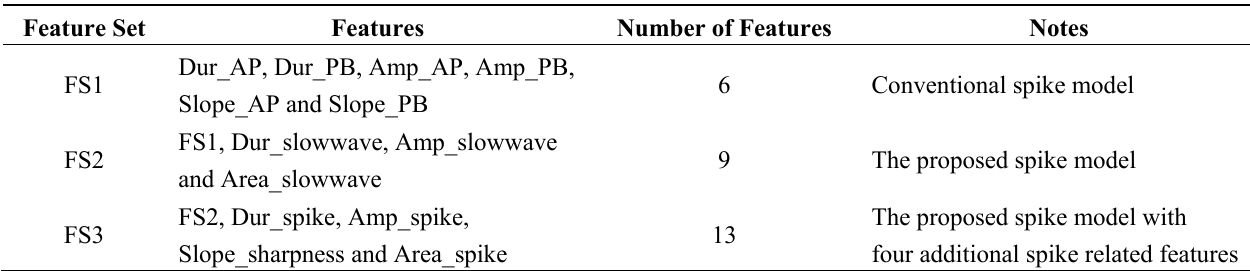
Table 3. Feature sets for different